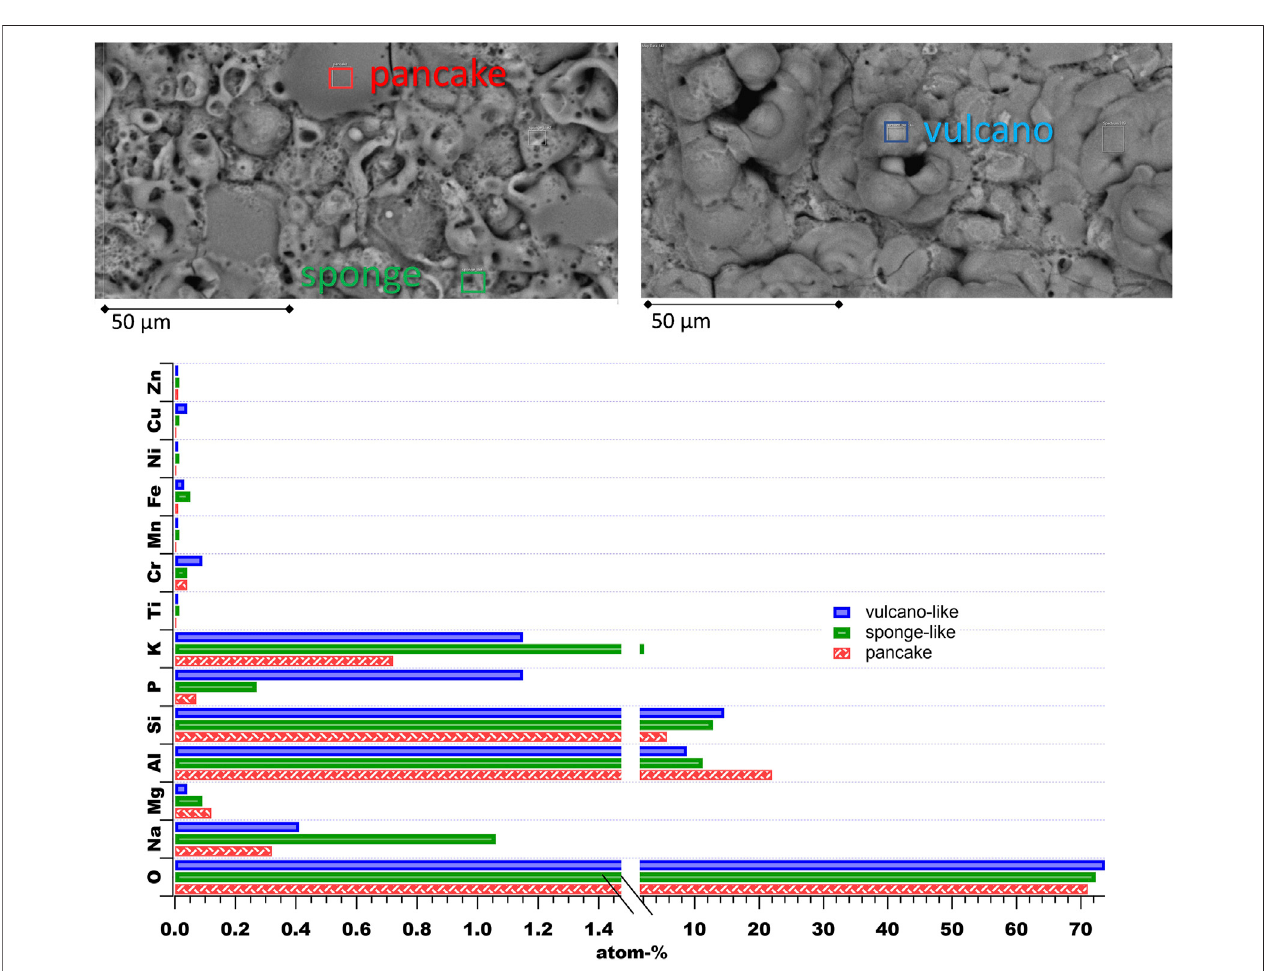
FIGURE 2 | Most prominent features of the applied PEO surfaces with their elemental contents from EDS analysis.